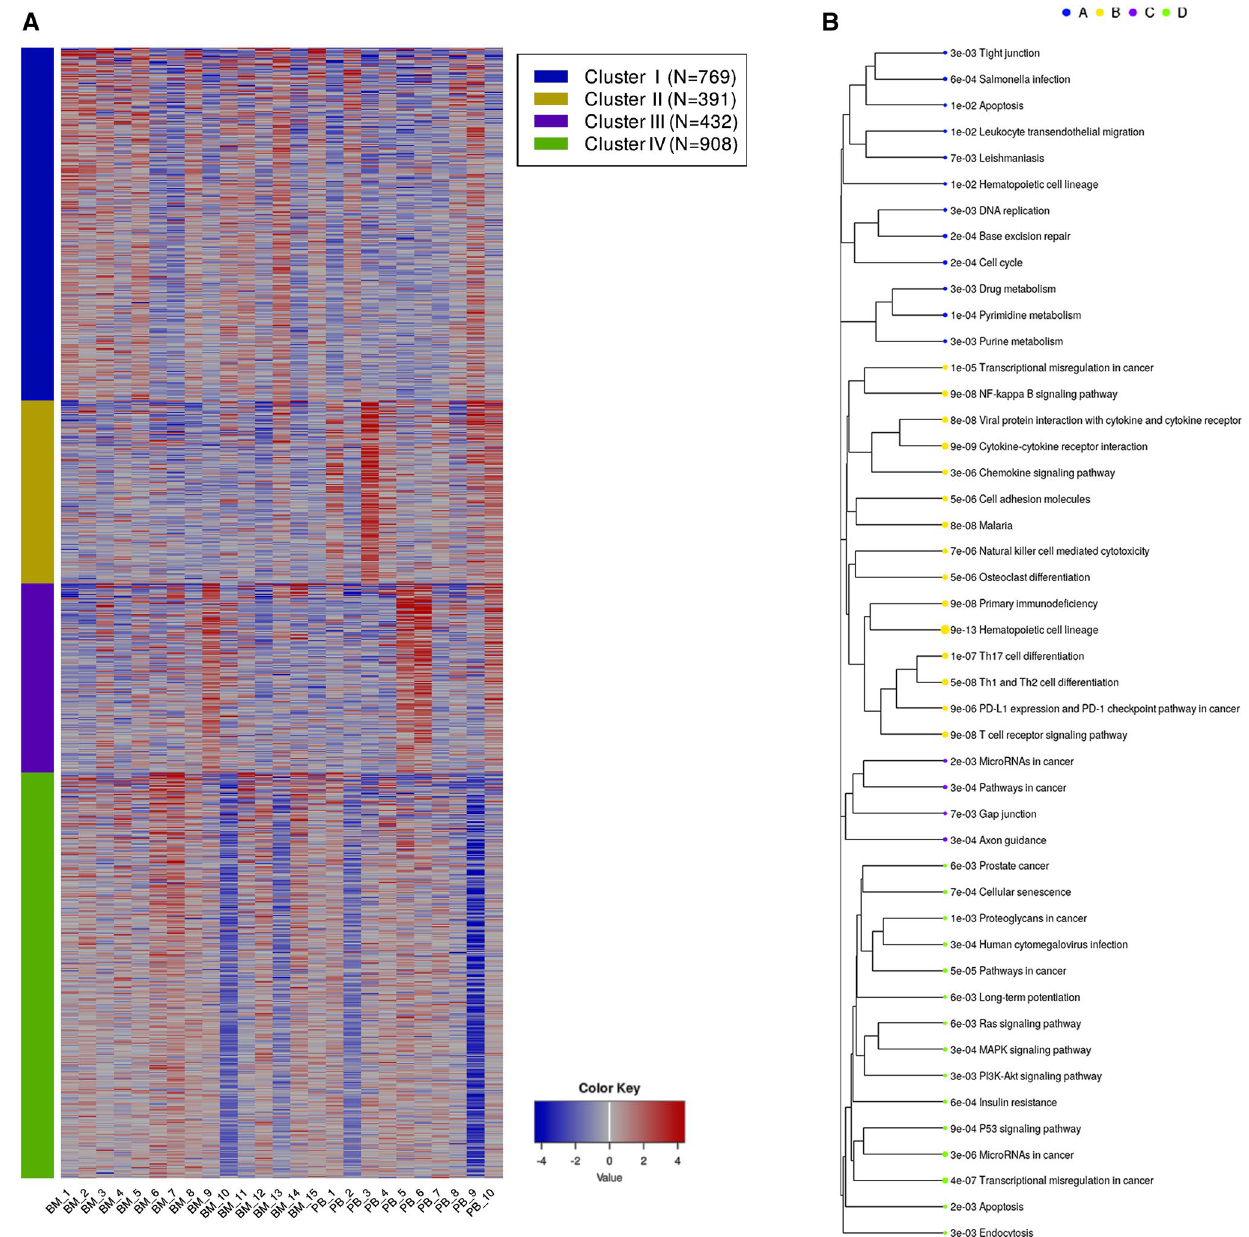
Fig. 6 Enrichment analysis. A Heatmap generated through the iDEP.92 tool showing gene clusters I, II, III and IV. B Network cluster showing significant pathways: Cell cycle (cluster I). Hematopoietic cell linage (cluster II). Cancer pathways (cluster III). Ras 8, MAPK, and PI3k-Akt sign- aling pathways (cluster